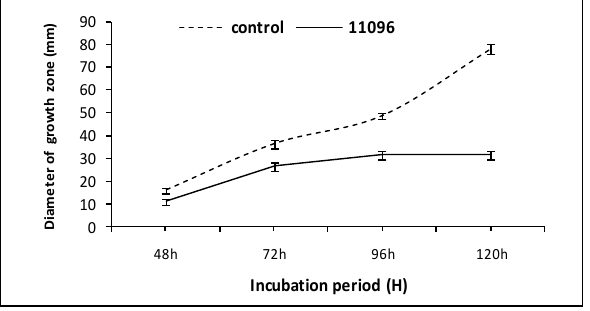
Figure 3. Effect of volatile secondary metabolites of Bga ICMP11096 on the growth rate of F. oxysporum. Data are expressed as a mean of three replicates ± SD.